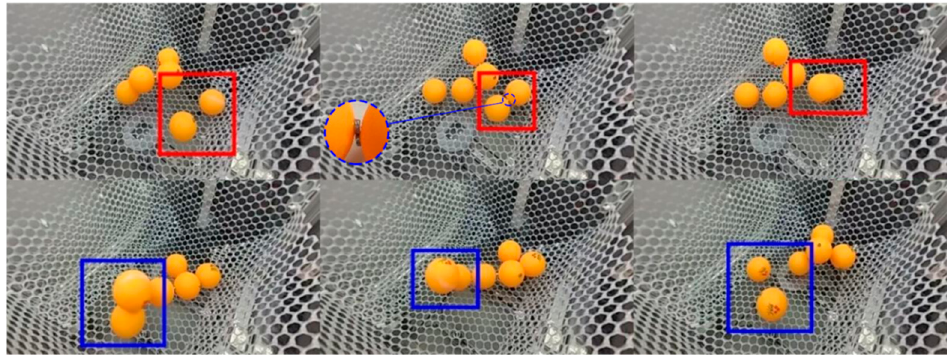
Figure 4. The error connection’s formation and correction. The red wireframe is the forming process, and the blue wireframe is the fracture process.